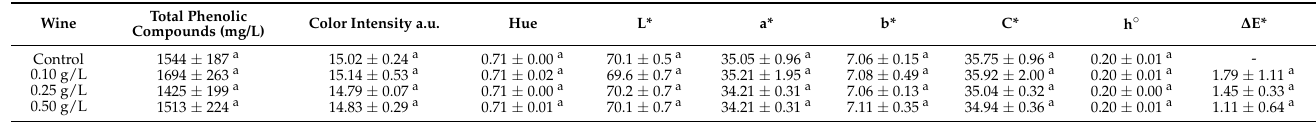
L* (lightness), a* (redness), b* (yellowness) coordinates, C* (chroma), h ◦ (hue-angle), ∆ E* (total color difference in relation to control wine). Values in the same column followed by the same letter are not significantly different ( n = 8) (Tukey’s HSD, p ≤ 0.05). a.u. (Absorbance